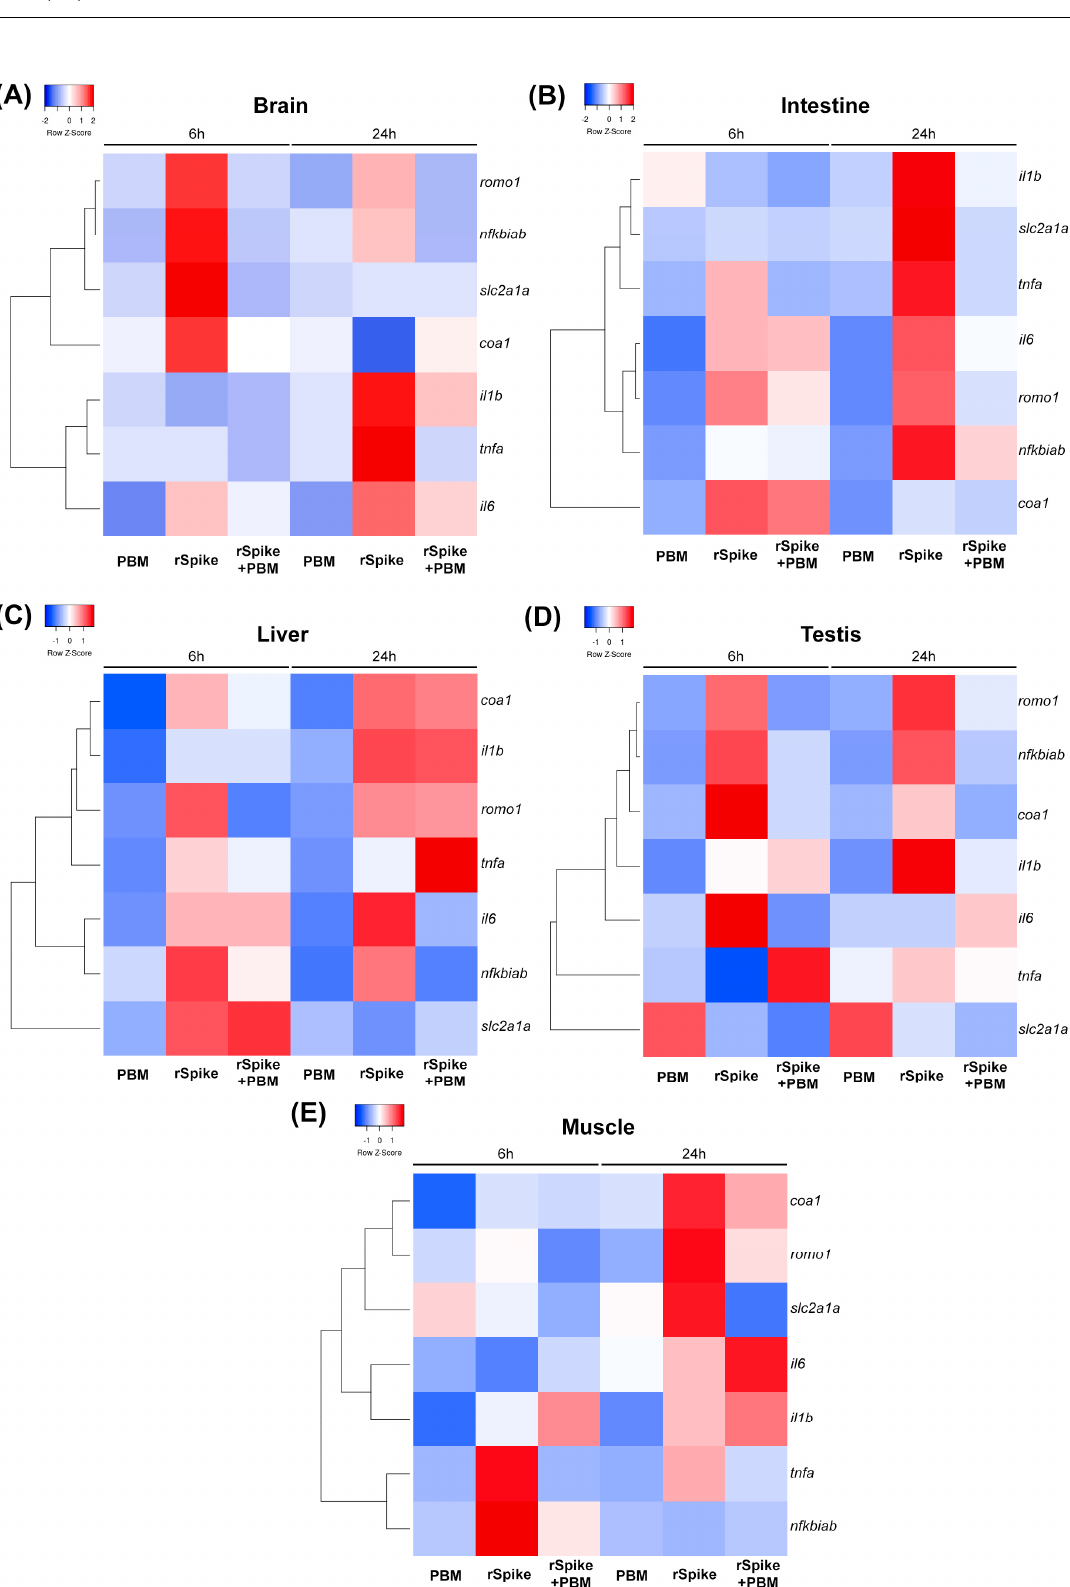
Figure 2. PBM with low-level laser as a potential therapeutic in pathologies originating from SARS- COV-2. Different tissue in ( A ) the brain, ( B ) intestine, ( C ) liver, ( D ) testis, and ( E ) muscle of zebrafish males, subjected to low-level laser (6 h and 24 h); injected with recombinant Spike protein (rSpike) and subsequently subjected to PBM (6 h and 24 h). Each colored cell on the map represents the normalized relative gene expression value for each treatment and sample. In each heat map, genes (rows) are grouped hierarchically using Pearson’s correlation as the distance